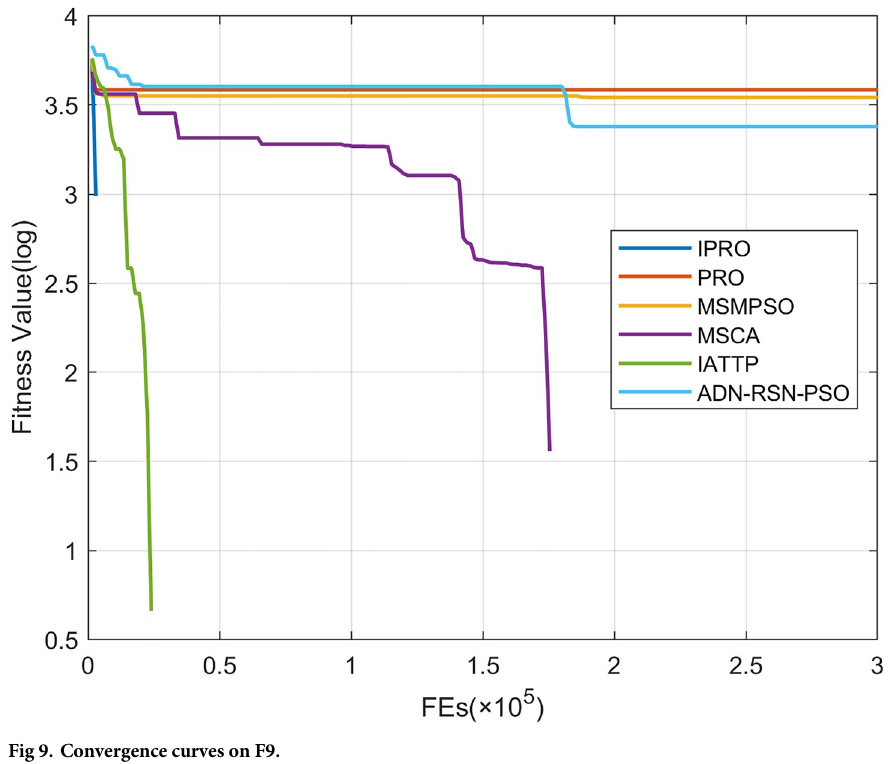
Fig 9. Convergence curves on F9.